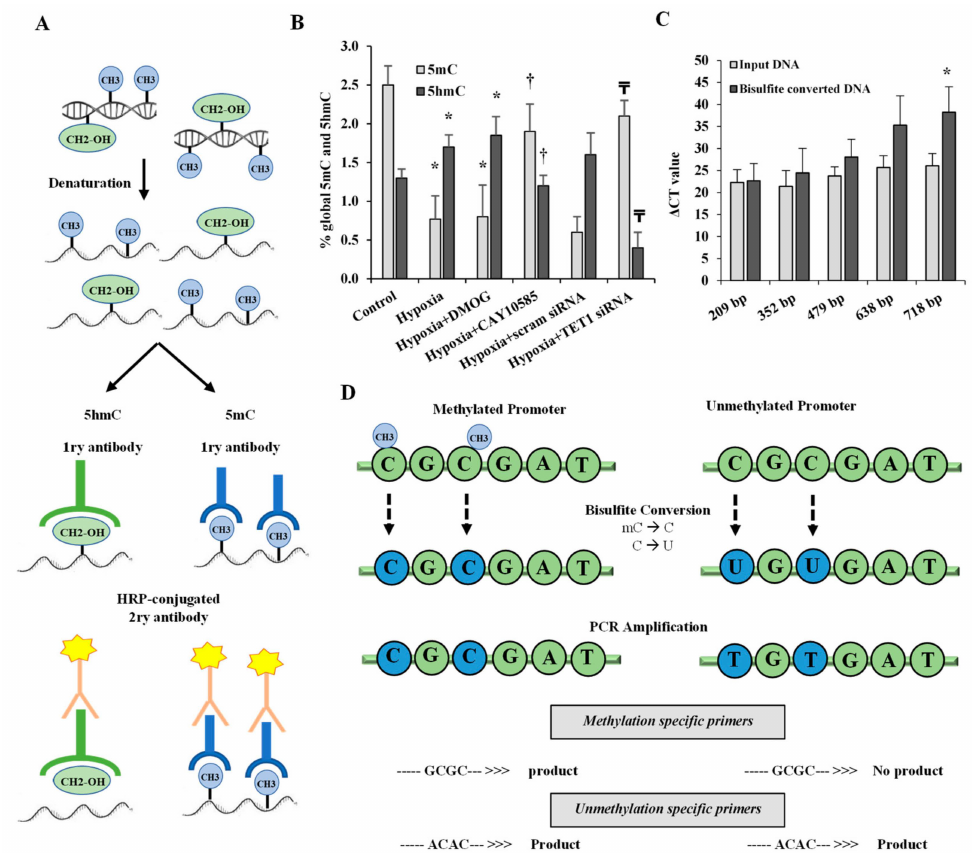
Figure 3. Effect of hypoxia on global DNA methylation and hydroxymethylation in differentiated Figure 3. E ff ect of hypoxia on global DNA methylation and hydroxymethylation in di ff erentiated adipocytes. ( A ) Illustration of the workflow for the 5 mC DNA and Quest 5hmC DNA ELISA Kits that were used to measure global DNA methylation and hydroxymethylation levels, respectively. ( B ) The percentage of global 5mC and 5hmC in primary differentiated adipocytes cultured under conditions of hypoxia ± DMOG, CAY10585, or silenced TET1 compared to standard culturing conditions (control). ( C ) To assess the quality of bisulfite converted DNA, Δ CT values were compared between bisulfite converted and input DNA for the amplification of several β -actin amplicons that ranged from 209 to 718 bp. ( D ) Outline of bisulfite conversion of genomic DNA where cytosine ( C ) is deaminated and converted to uracil (U) while methylated cytosine (mC) is protected and maintained as cytosine. Methylation-specific and unmethylation-specific primers are designed to detect methylated vs. unmethylated DNA, respectively. Results represent the means ± SD for three independent experiments in triplicates for each treatment (n = 9). (* p < 0.05) for comparison with control and ( † p <0.05) for comparison with hypoxia and ( ₸ p <0.05) for comparing hypoxia + TET1 siRNA and hypoxia + scram